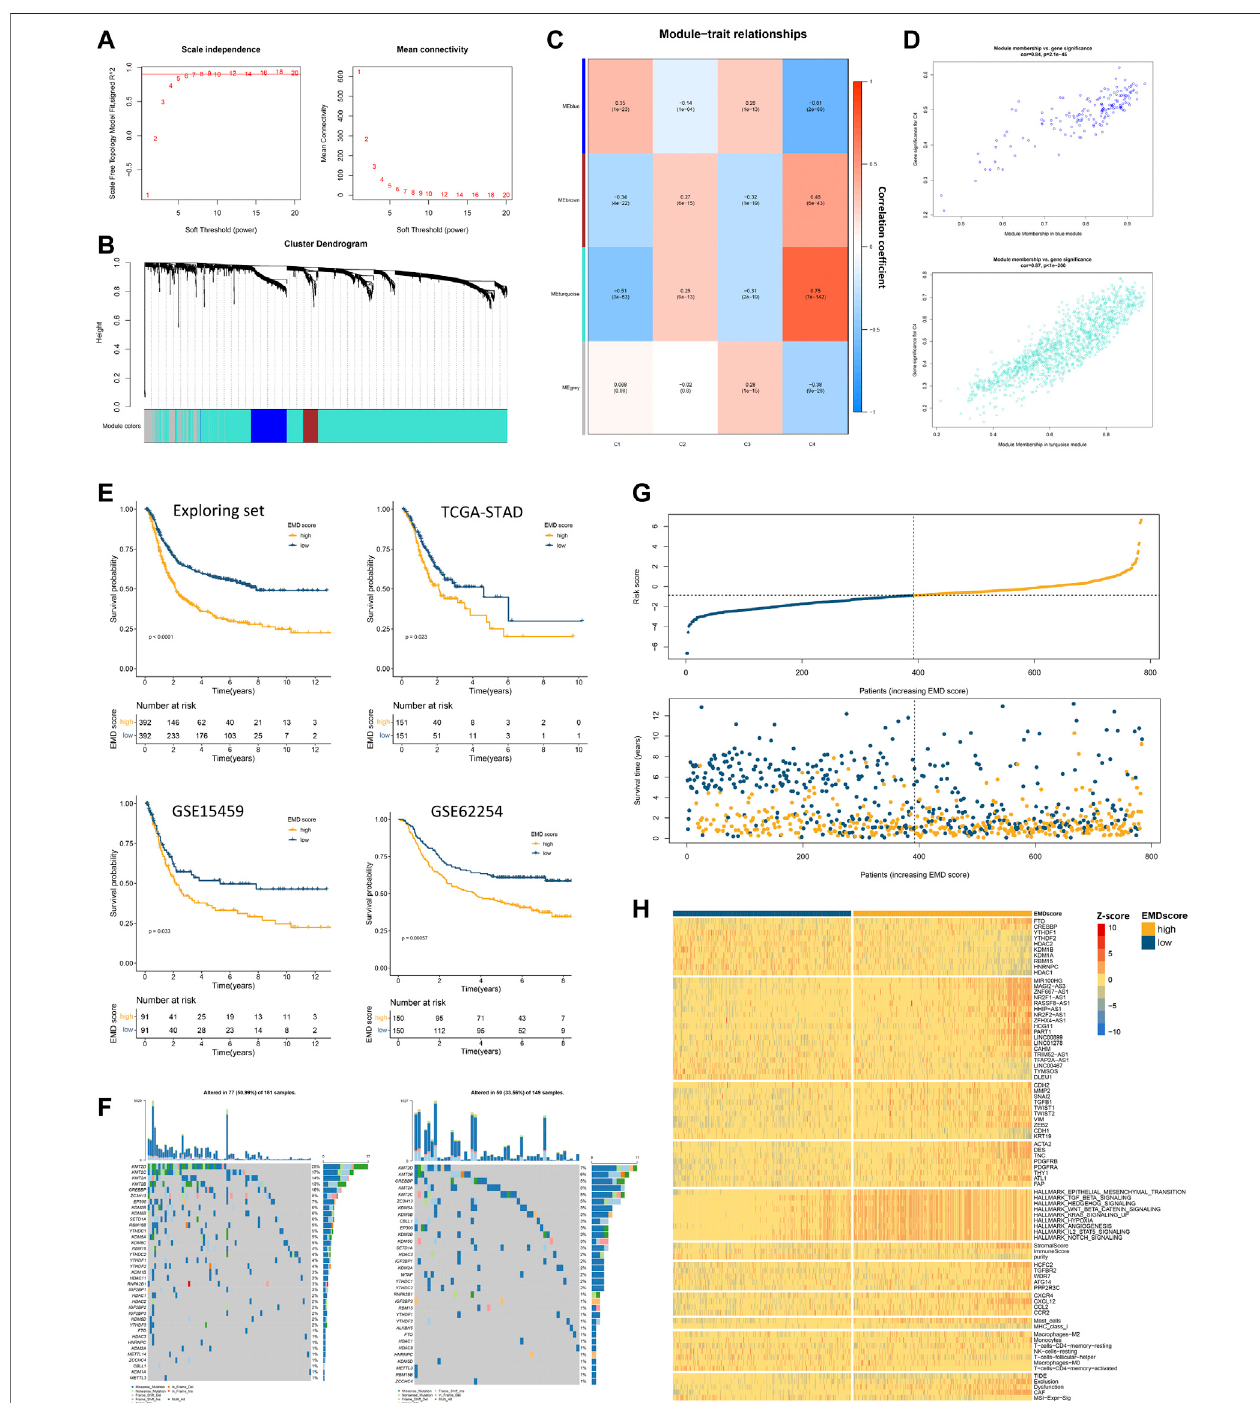
FIGURE6| ConstructionoftheEMDscoreintheexploringset. (A – D) WGCNAanalysisbasedon1674DEGsintheexploringset. (E) Kaplan – Meiercurvesshowed the different overall survival between the high- and low-EMD score groups in the exploring set. Patients were separated into the high and low groups according to the median EMD score of each cohort. (F) Mutation landscape of epigenetic regulators in high- and low-EMD score groups in the TCGA-STAD cohort. (G) Risk curves showed more frequent death events with the increasing EMD score in the exploring set. Dots in yellow referred to death events observed in the cohorts. (H) HeatmapshowedtheclosecorrelationsoftheEMDscorewithvarious molecularcharacteristicsincludingepigeneticregulators,EMRLs,TMEmarkers,oncogenes,and tumorigenic pathways. All the values were scaled using the Z-score.